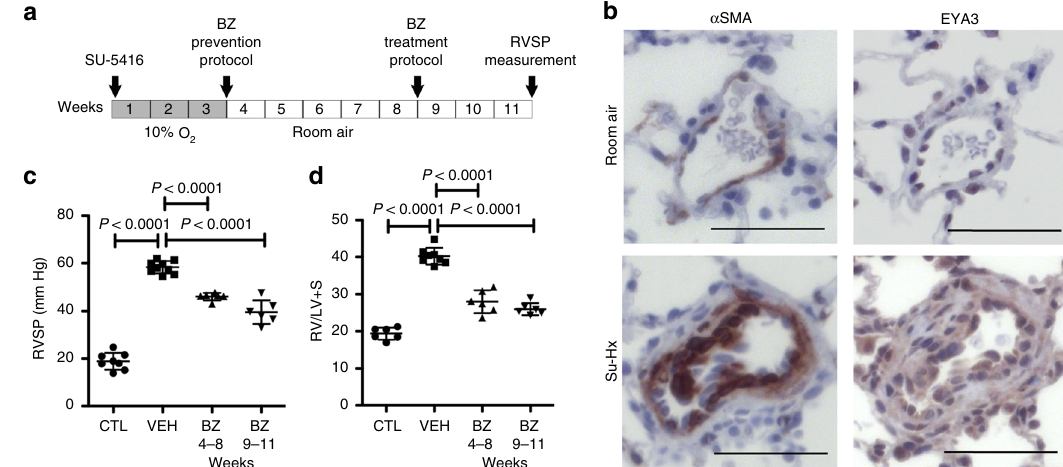
Fig. 3 EYA-PTP inhibitor Benzarone reduces RVSP and RV hypertrophy. a Protocol for the rat Sugen-hypoxia (Su-Hx) model and BZ administration schedule. Adult rats were administered SU-5416, then placed in a hypoxia chamber for 3 weeks. After return to room air, start of BZ treatment (BZ